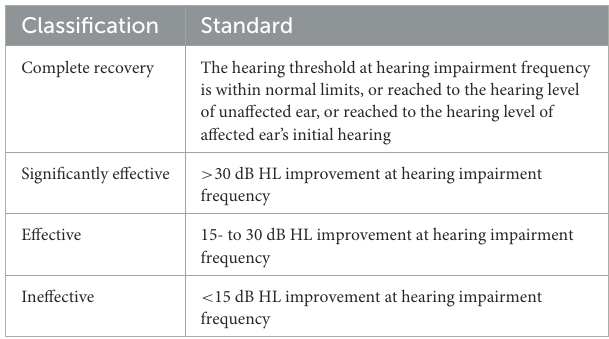
TABLE 2 Classification and standard of hearing